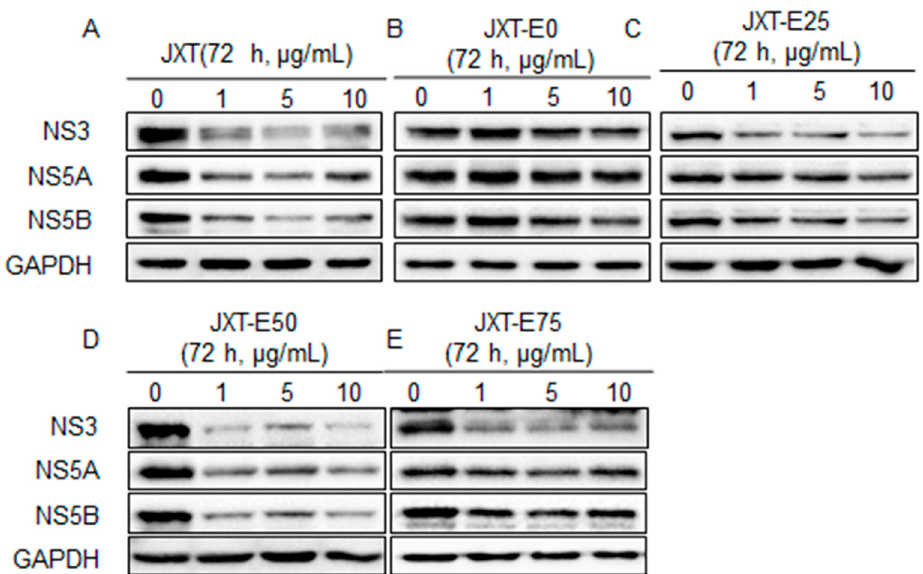
Figure 2. Expression levels of HCV NS proteins with the treatment of ( A ) JXT; ( B ) JXT-E0; ( C ) JXT-E25; ( D ) JXT-E50, and ( E ) JXT-E75 extracts. Huh-luc/neo-ET cells were seeded in a 6-well plate, and treated with different concentrations of JXT fractions for 72 h. The cells were collected and lysed, and 30 ng of the total protein was subjected to SDS PAGE and western blot. The expression levels of NS3, NS5A, and NS5B were determined. The expression level of GAPHD was used as the housekeeping control. The results are representative of three independent experiments.